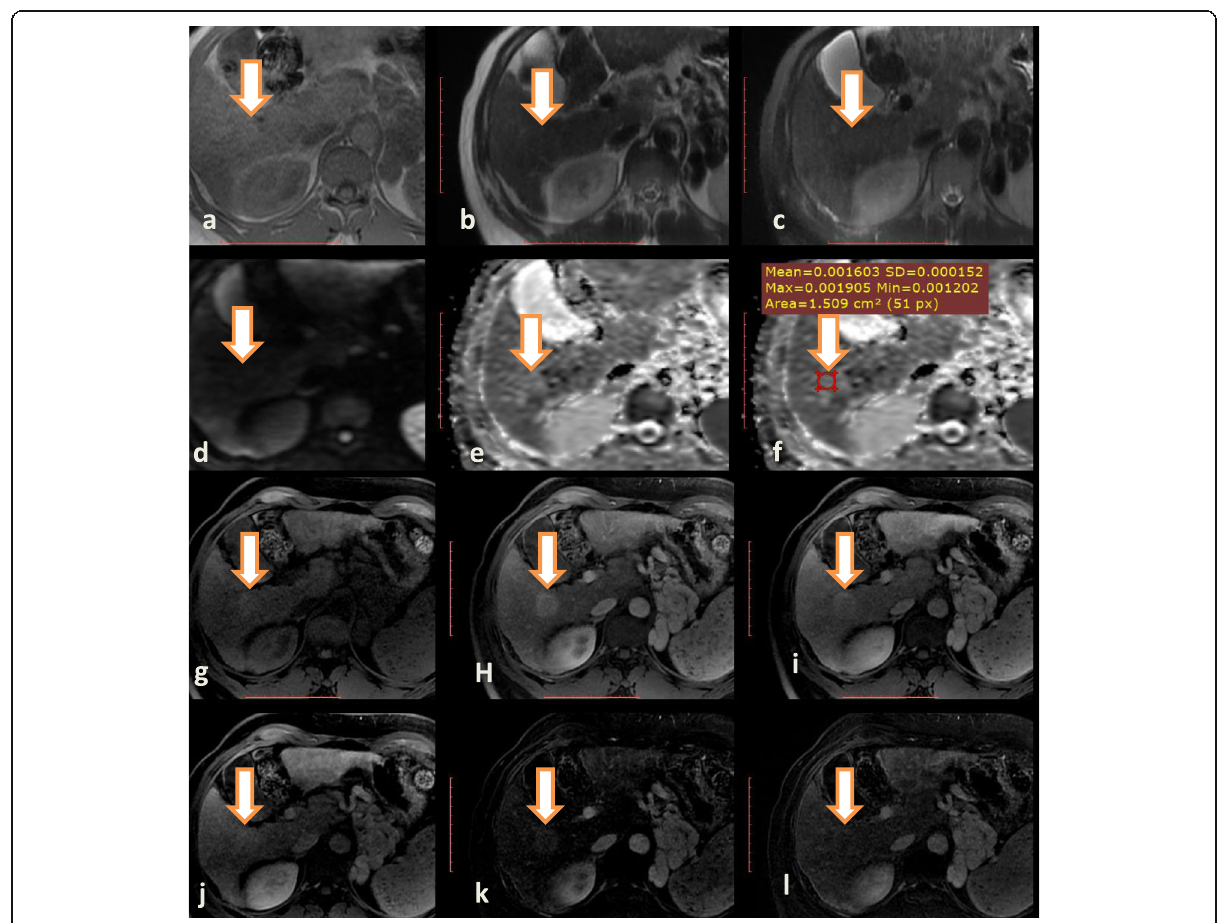
Fig. 4 1st follow-up DCE MRI with DWI after 1 month for a 55-year-old male patient with chronic viral hepatitis C diagnosed as HCC involving right hepatic lobe segment VI underwent TACE ablation with still elevated AFP level. a Treated lesion showed faint high in T1 WIs. b Faint high signals T2 WIs. c Faint high signals STIR WIs. d Facilitated diffusion in DWI at 800 b value. e Corresponding bright signals in ADC mapping series. f